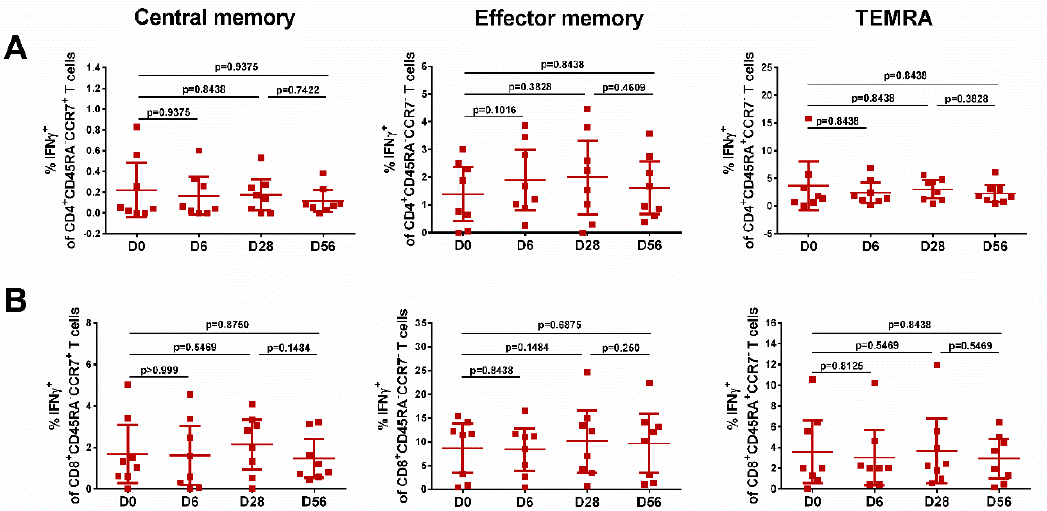
Figure 6. Different populations of cytokine-producing CD4 ( A ) and CD8 ( B ) T cells in subjects who received placebo. Individual data are shown, along with means ± 95% CI. T cell levels at different time-points were compared using the Wilcoxon matched-pairs test.